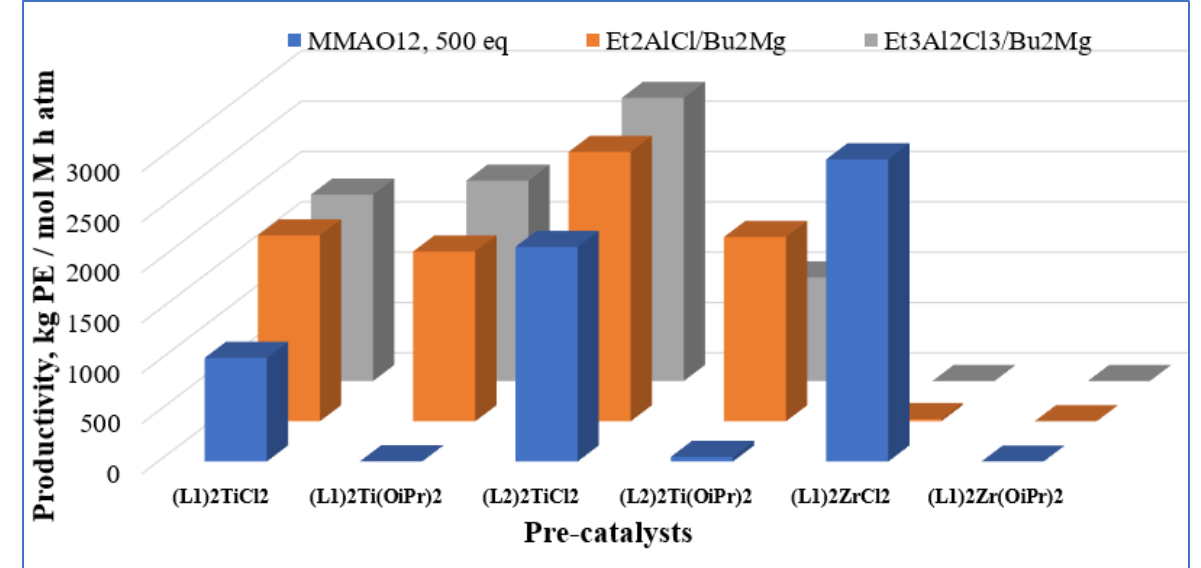
Figure 3. Dependence of the activity of the catalyst systems in ethylene polymerization on the catalyst system composition. The cocatalyst ( i Bu) 3 Al/CPh 3+ B(C 6 F 5 ) 4 − turned out to be ineffective on the whole. Only